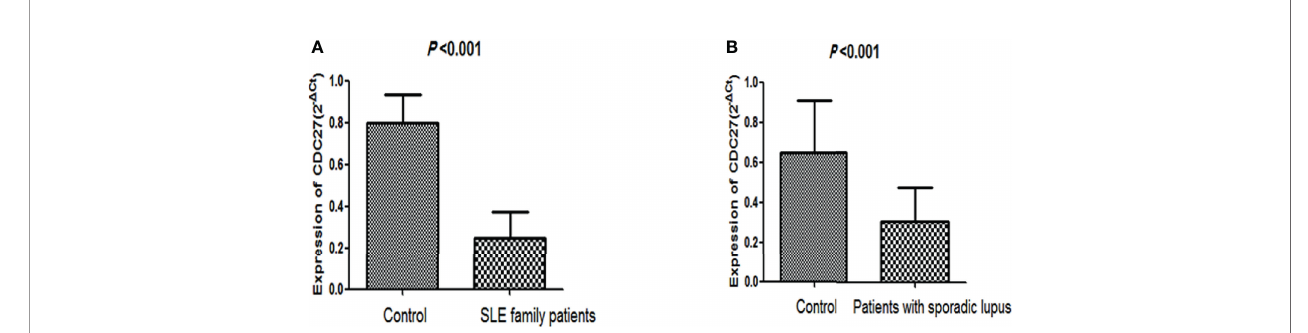
FIGURE 4 | Comparison of CDC27 expression levels between healthy controls and lupus patients. (A) Comparison of healthy controls and family patients with lupus; (B) comparison of healthy controls and sporadic lupus